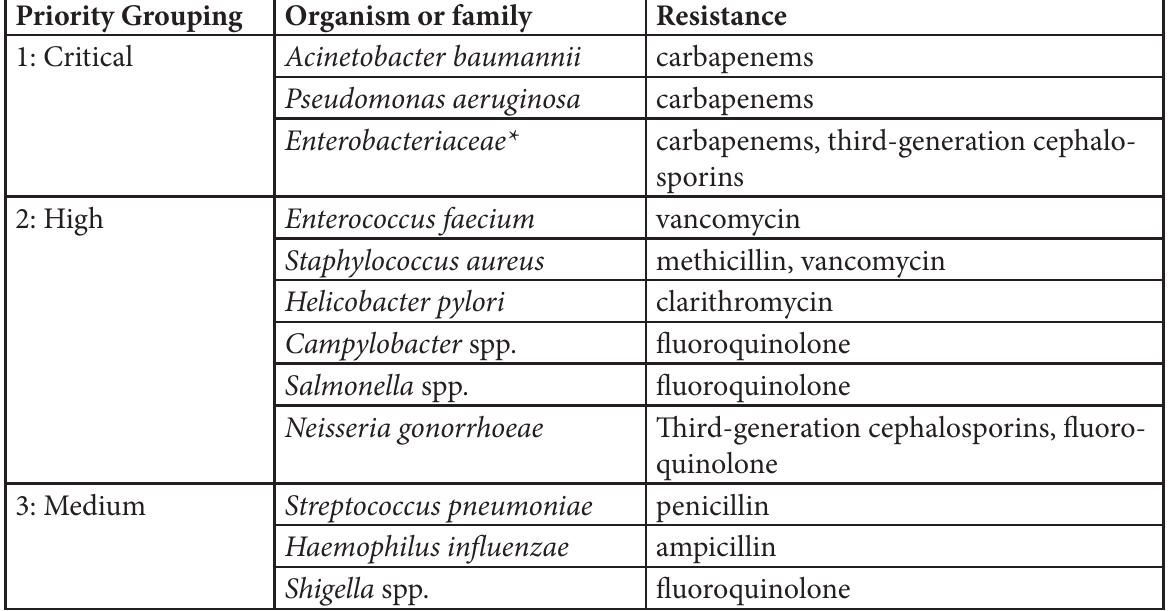
Table 1 . WHO priority list of antibiotic resistant bacteria Priority